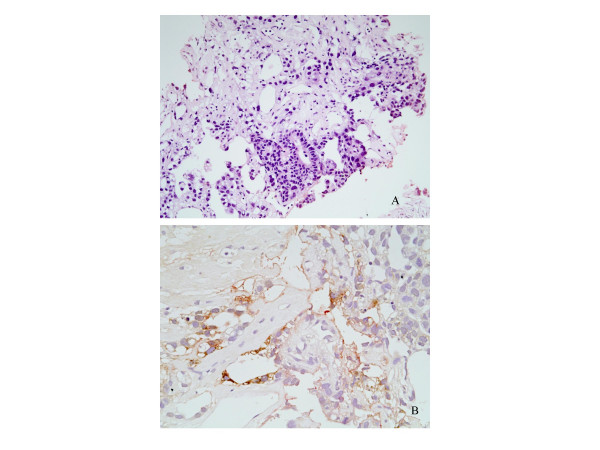
Photomicrograph of extragonadal non-seminomatous germ cell tumor with a focus of yolk sac tumor. A: H&E section shows characteristic structures suggestive of Schiller-Duval bodies (×200). B: Alpha-fetoprotein immunohistochemical stain is focally positive at the above area (×400).